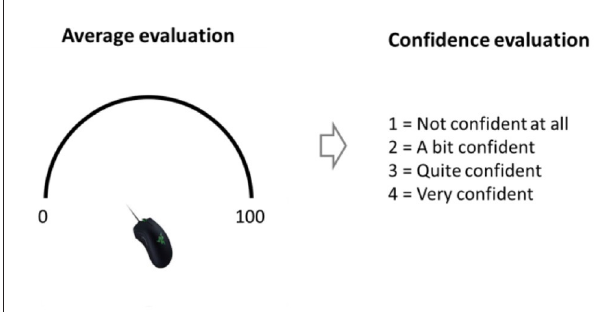
FIGURE 9 | Response scale and confidence response in Experiment 3.